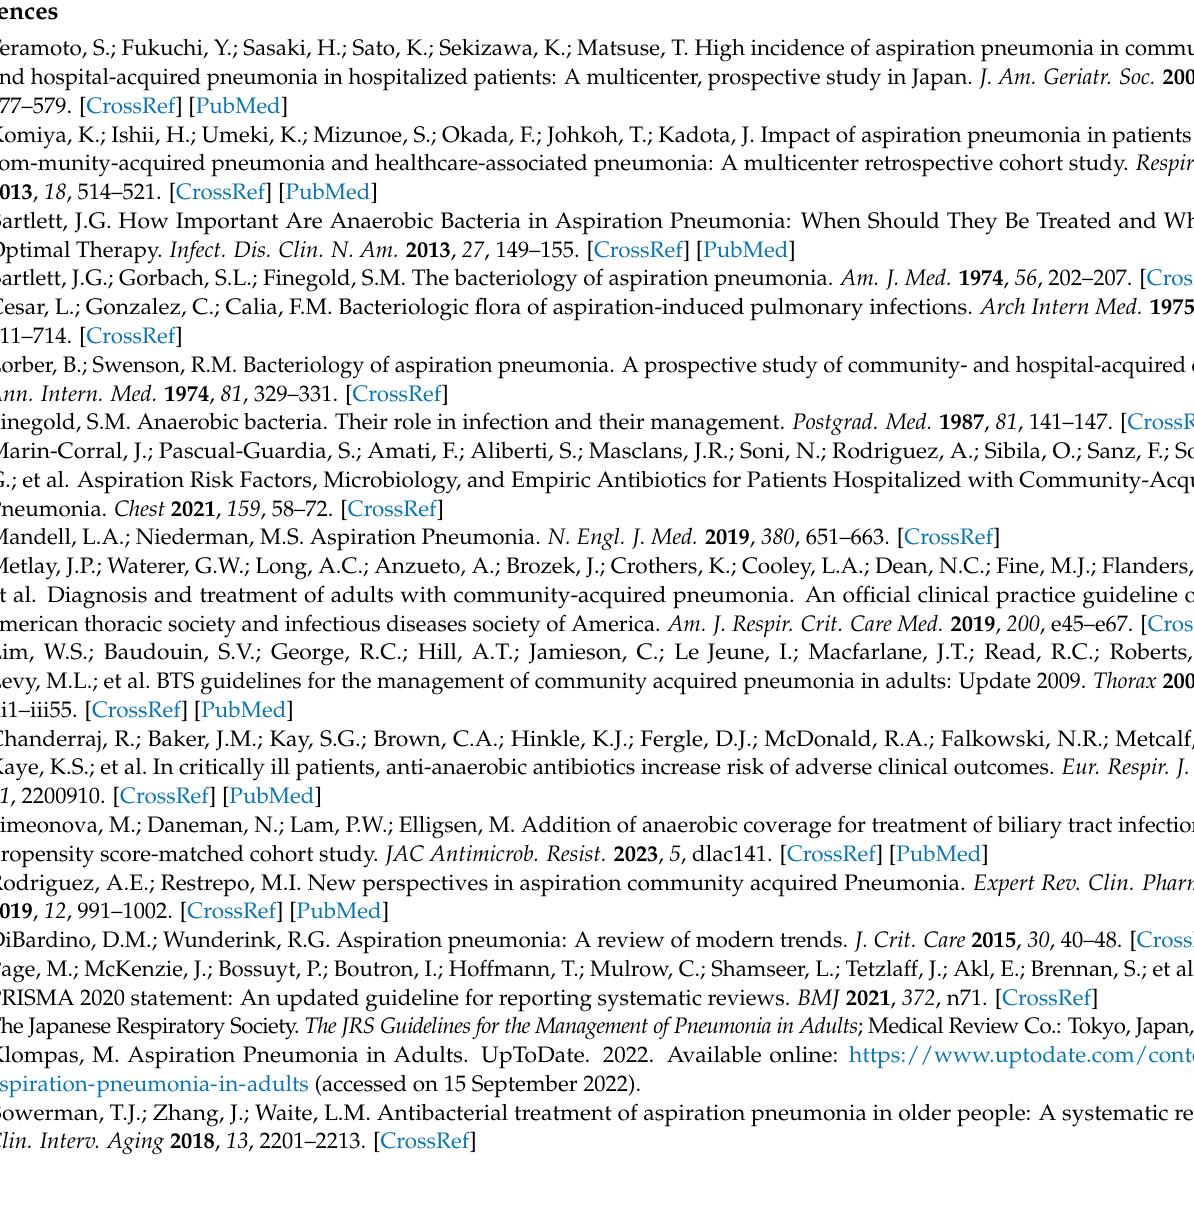
Figure A1. Funnel plots. ( A ) Mortality, ( B ) Clinical cure rate.